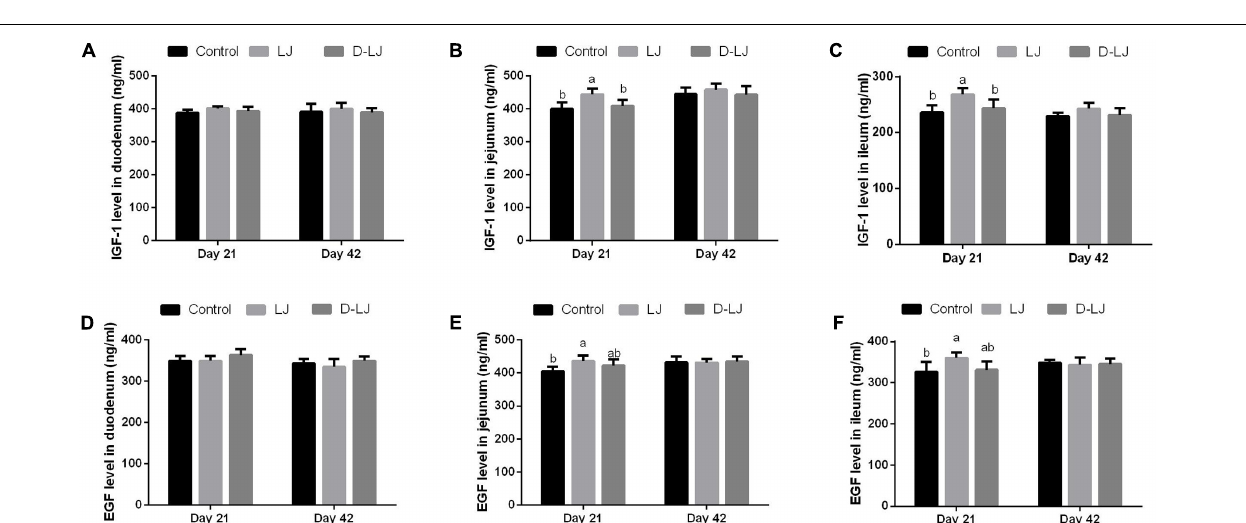
Frontiers in Microbiology |